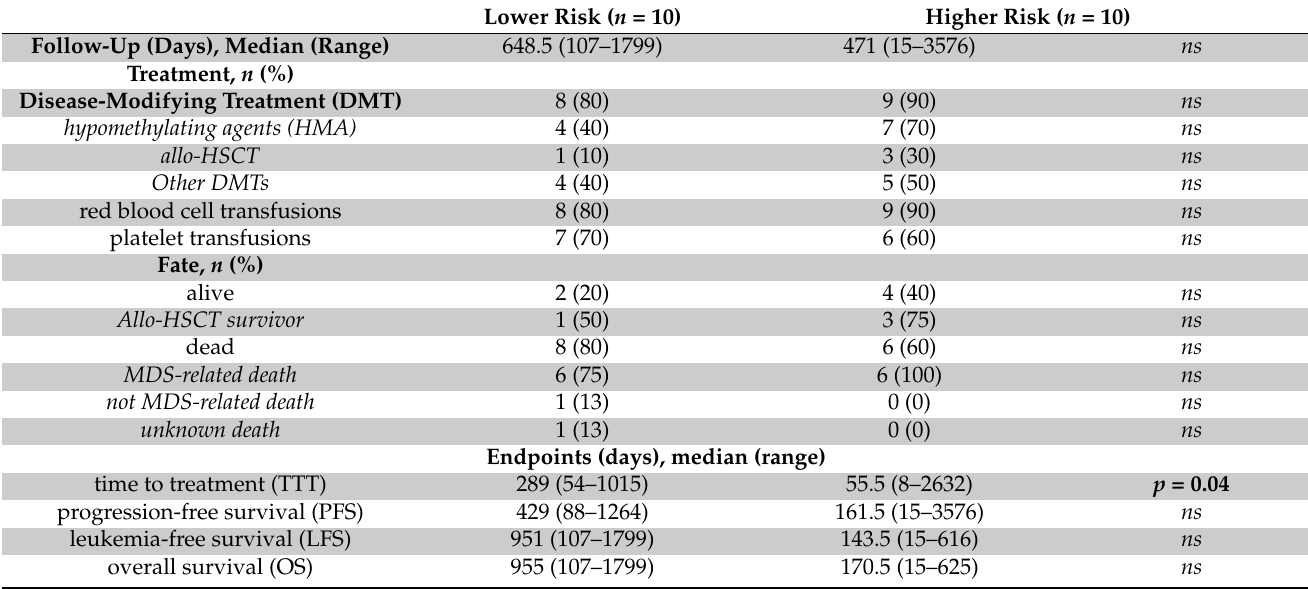
Table 3. Follow-up and endpoints in MDS